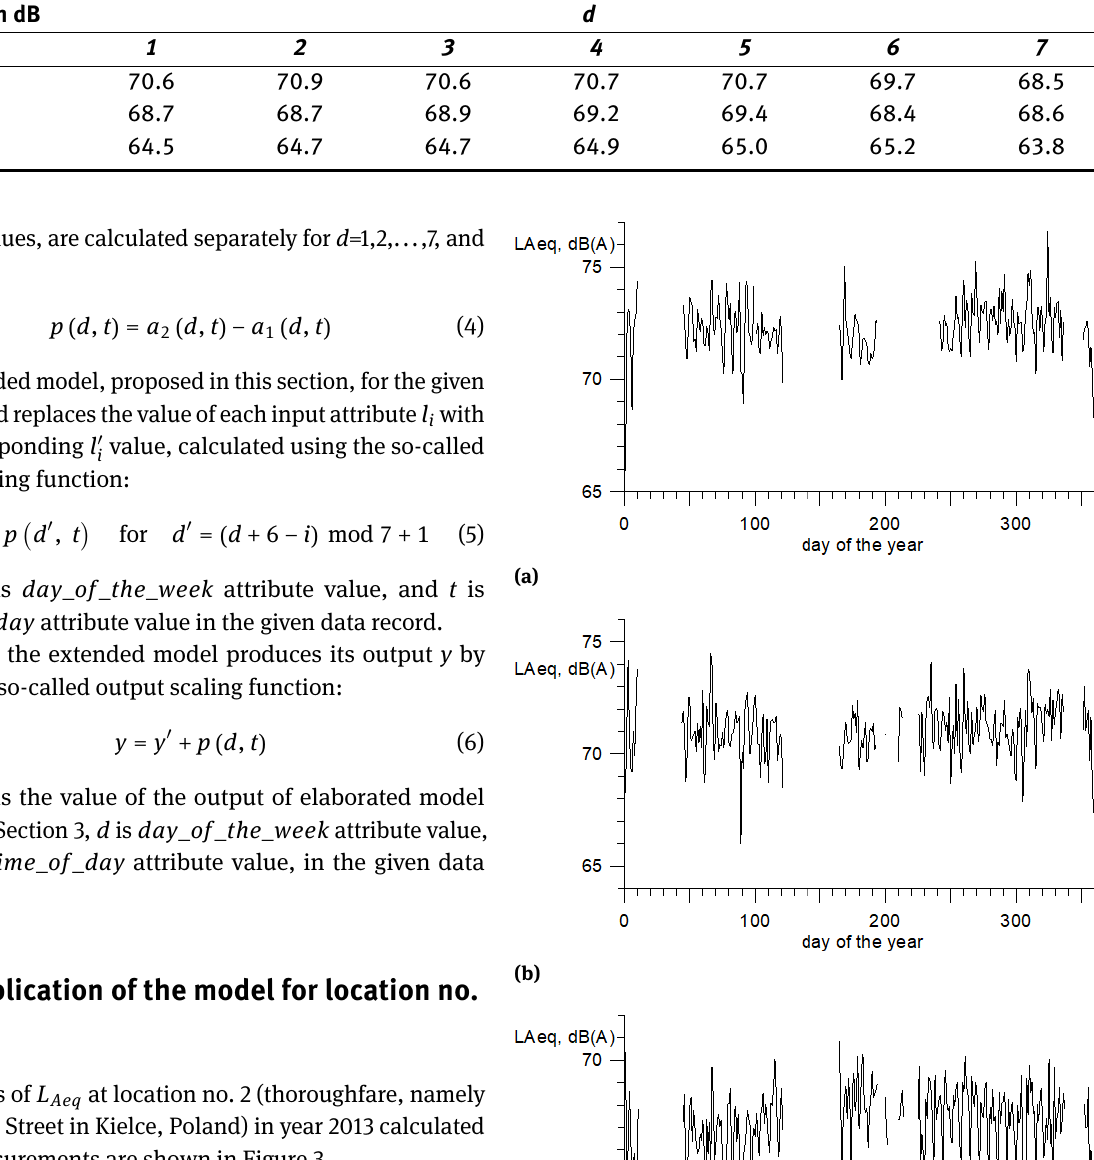
Table 3: Values of a ( d , t ) in dB, for location no. 1 a(d,t) , in dB